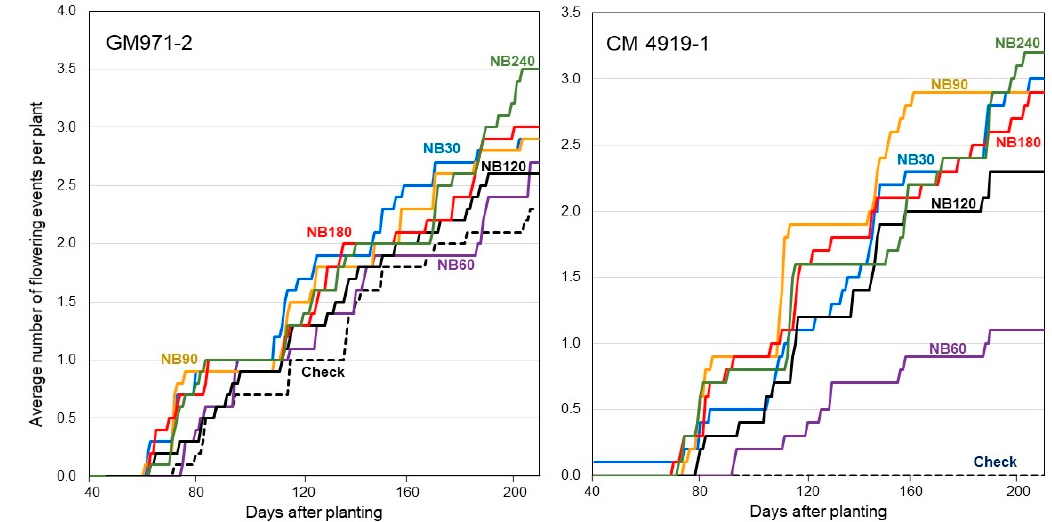
Figure 6. Effect of night breaks on the flowering patterns of two cassava genotypes. Results are based on ten plants per genotype and night break (NB) treatments were applied for various durations, centered on midnight. An intermediate light intensity was used for NB30. NB60, NB120, and NB180 were based on a low-intensity illumination. NB90 and NB240 were illuminated with a high intensity red-light source. See Methods and Materials for details.